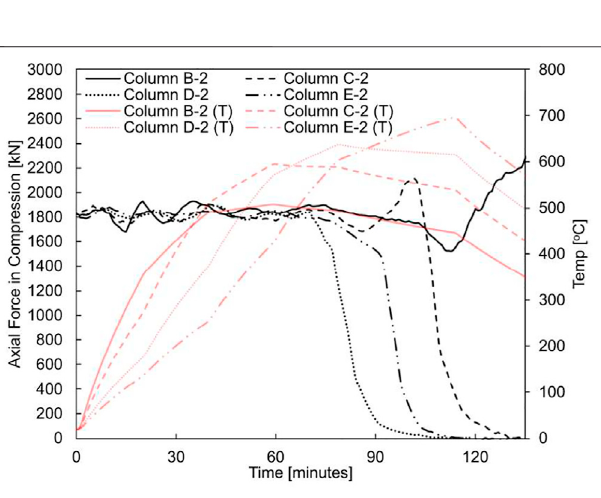
FIGURE 15 | Axial force history of gravity columns in Fire Scenario